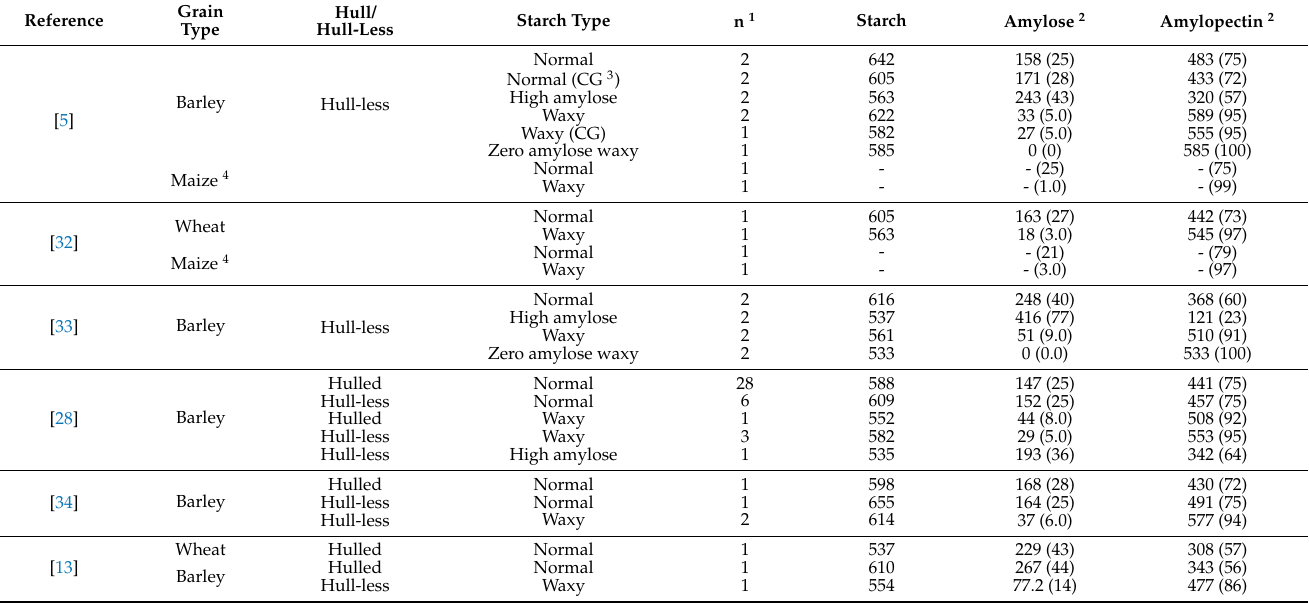
Table 1. Comparison of starch in maize, wheat, hulled barley and hull-less barley types (g/kg, DM